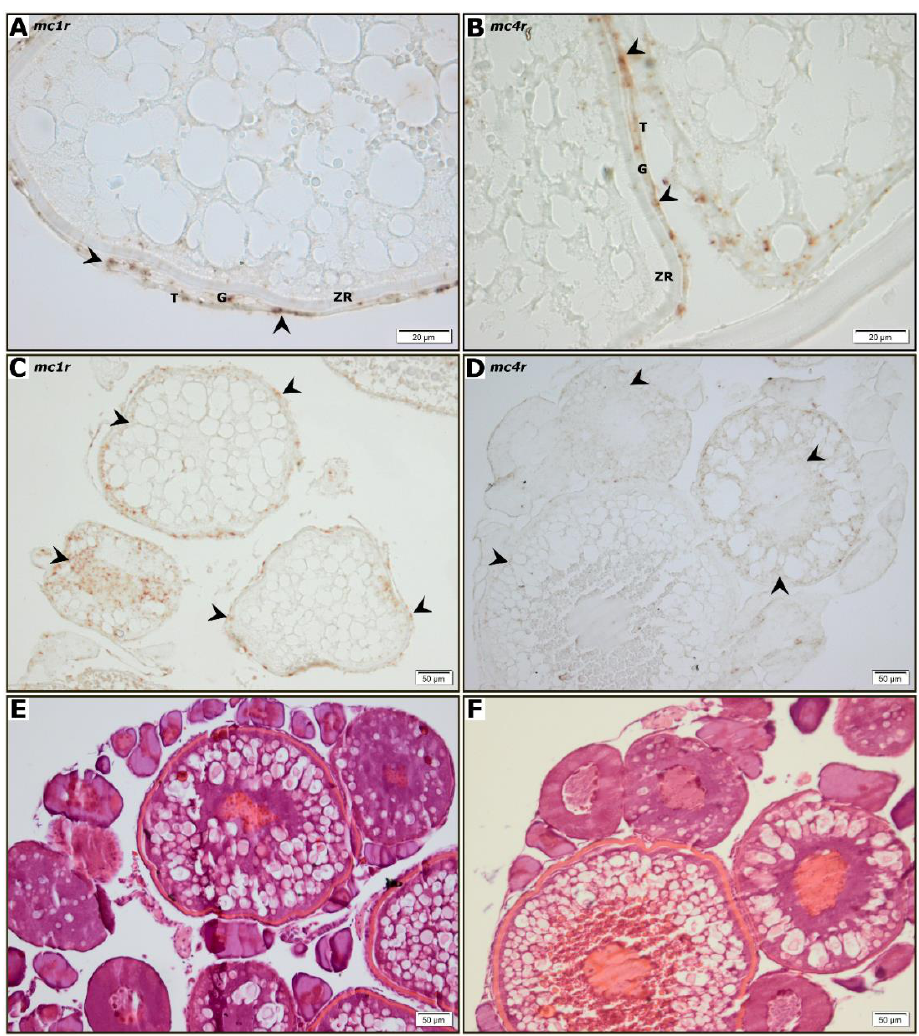
Figure 2. Localization of mcr1 and mcr4 transcripts expression in the zebrafish ovary by in situ hybridization. Panels ( A,B ) show mc1r and mc4r expression in the follicular cells, respectively. Panels ( C , D ) display mc1r and mc4r expression in the previtellogenic and vitellogenic follicles of the zebrafish ovary. ( E , F ) are representative tissue sections of ( C , D ) stained with haematoxylin-eosin, respectively. Signal was absent in the interstitial region.